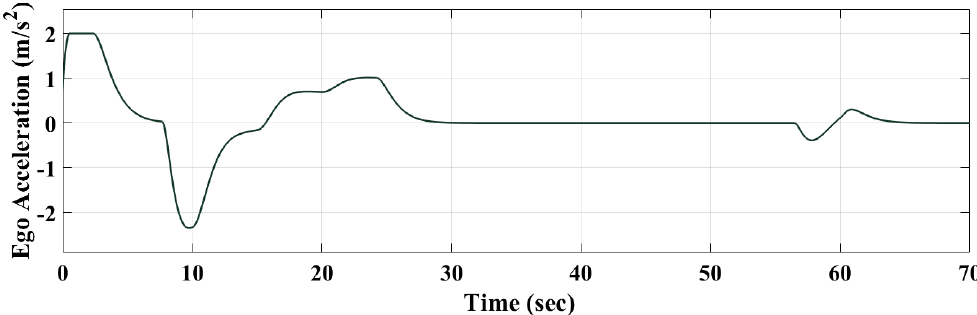
Figure 14. MPC-based controller’s response—MATLAB